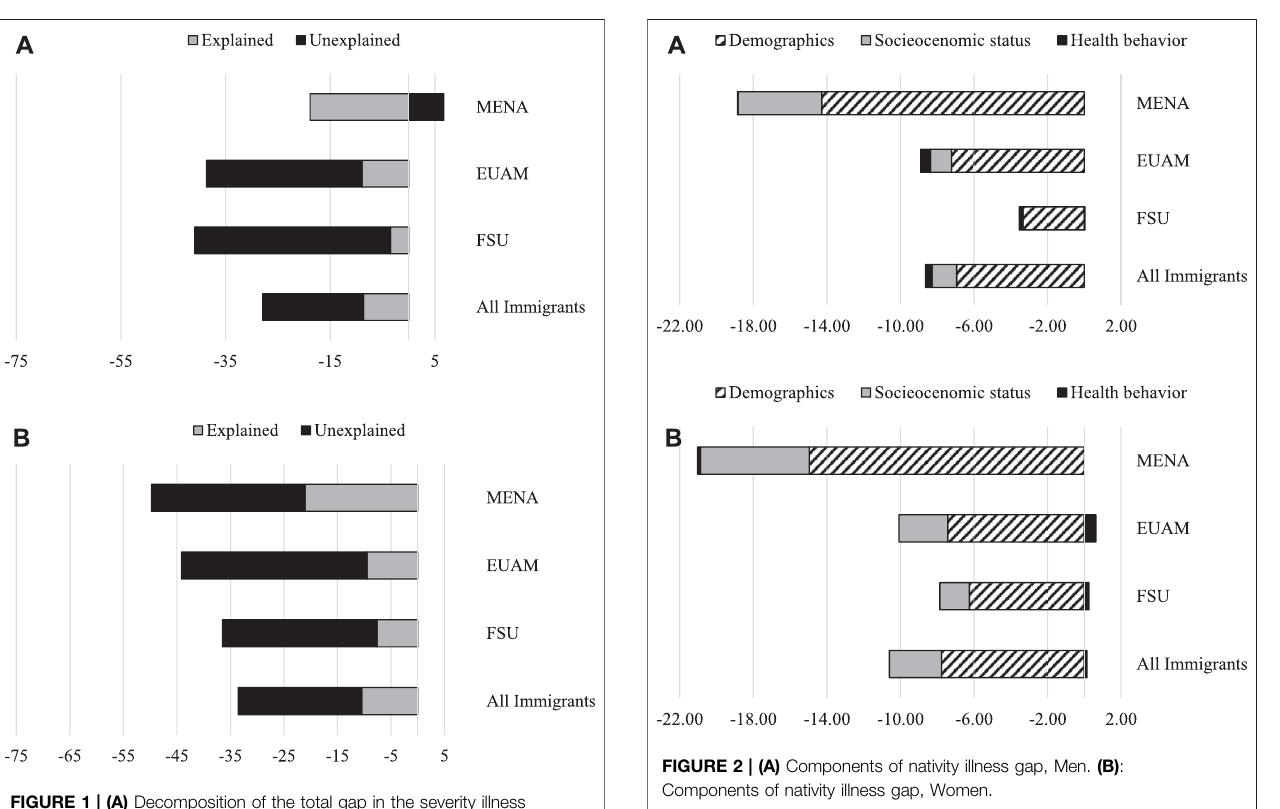
Frontiers in Sociology |